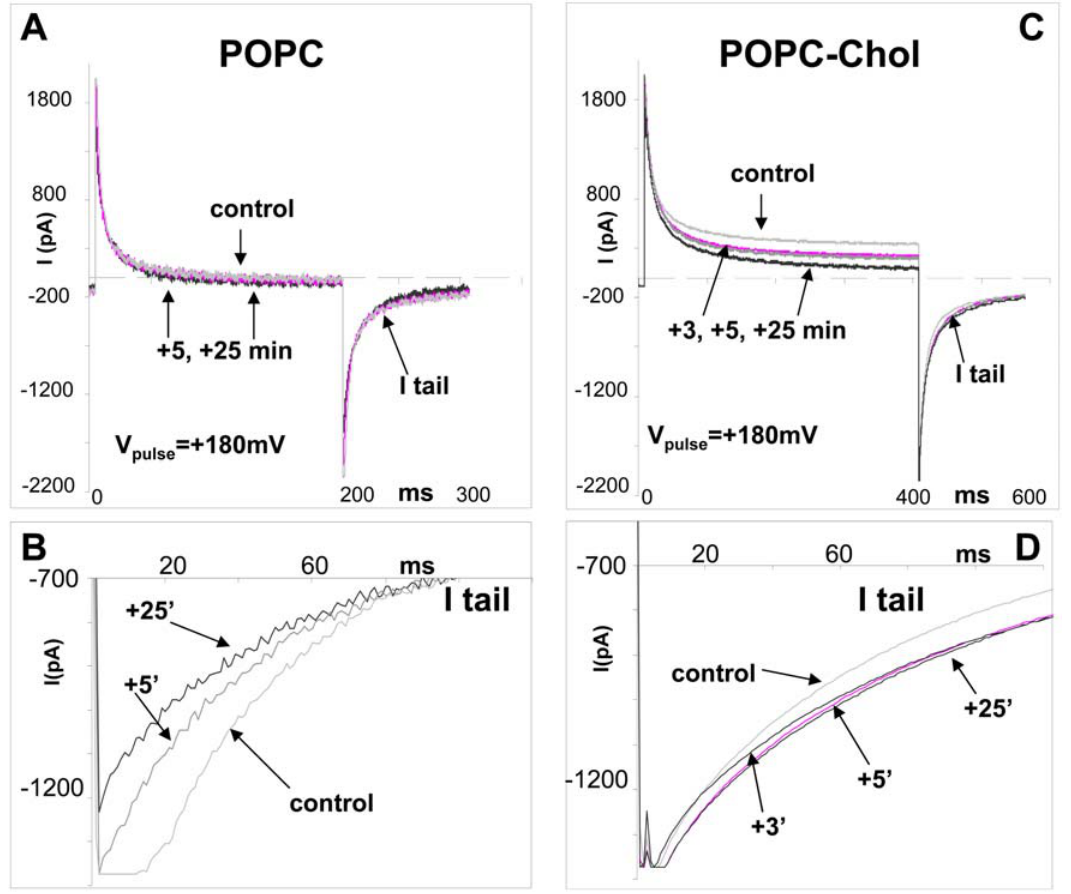
Figure 7. Action of anandamide (AEA, 400 m M) on planar lipid bilayers: effect of cholesterol. A–B . superimposed currents across a bilayer constituted of POPC alone ( A ), held at 0 mV, in response to a rectangular pulse ( + 180 mV, 200 ms), before (control, light grey bilayer alone), and after addition of anandamide (heavy grey, + 5, + 25 min after AEA injection). B . Expanded view of tail currents (I tail) showing their decrease over time. C–D . POPC-cholesterol (2:1, mol:mol). AEA injection ( C ) stably increased both resistance and capacitance. Maximum effect was obtained for all POPC- cholesterol bilayers within 3–5 min. Each current trace represents the average of 6 records.